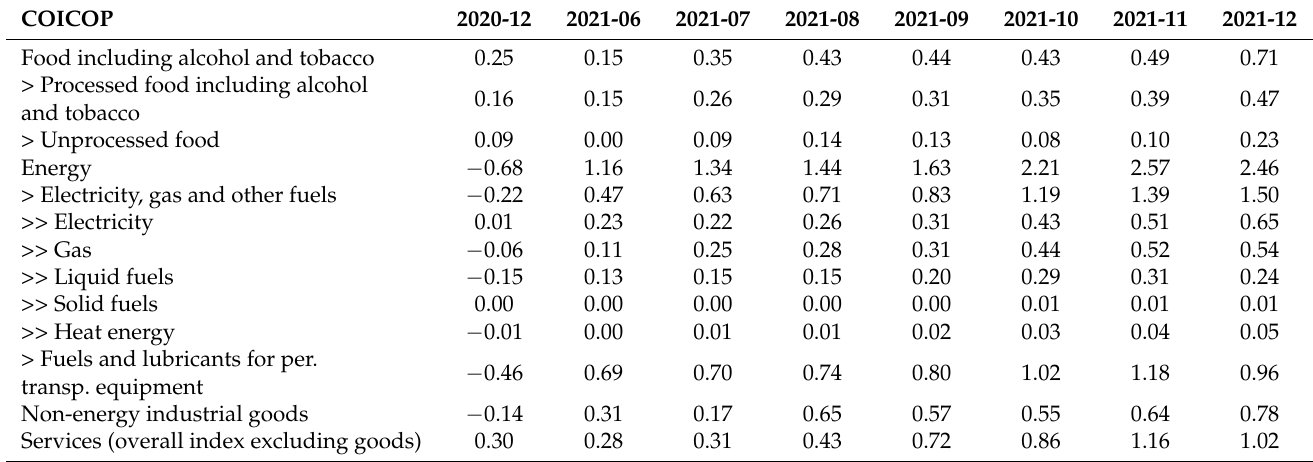
Table 1. Contributions to the Euro Area Annual Inflation Rate (pp), Selected